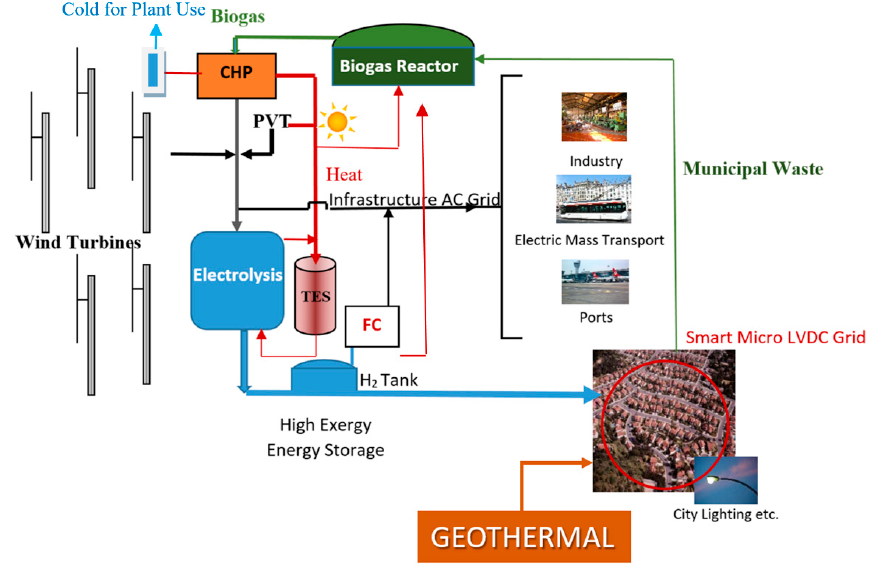
Figure 4. Hydrogen-Solar-Wind District Plant in the Energy-Water-Environment Nexus.